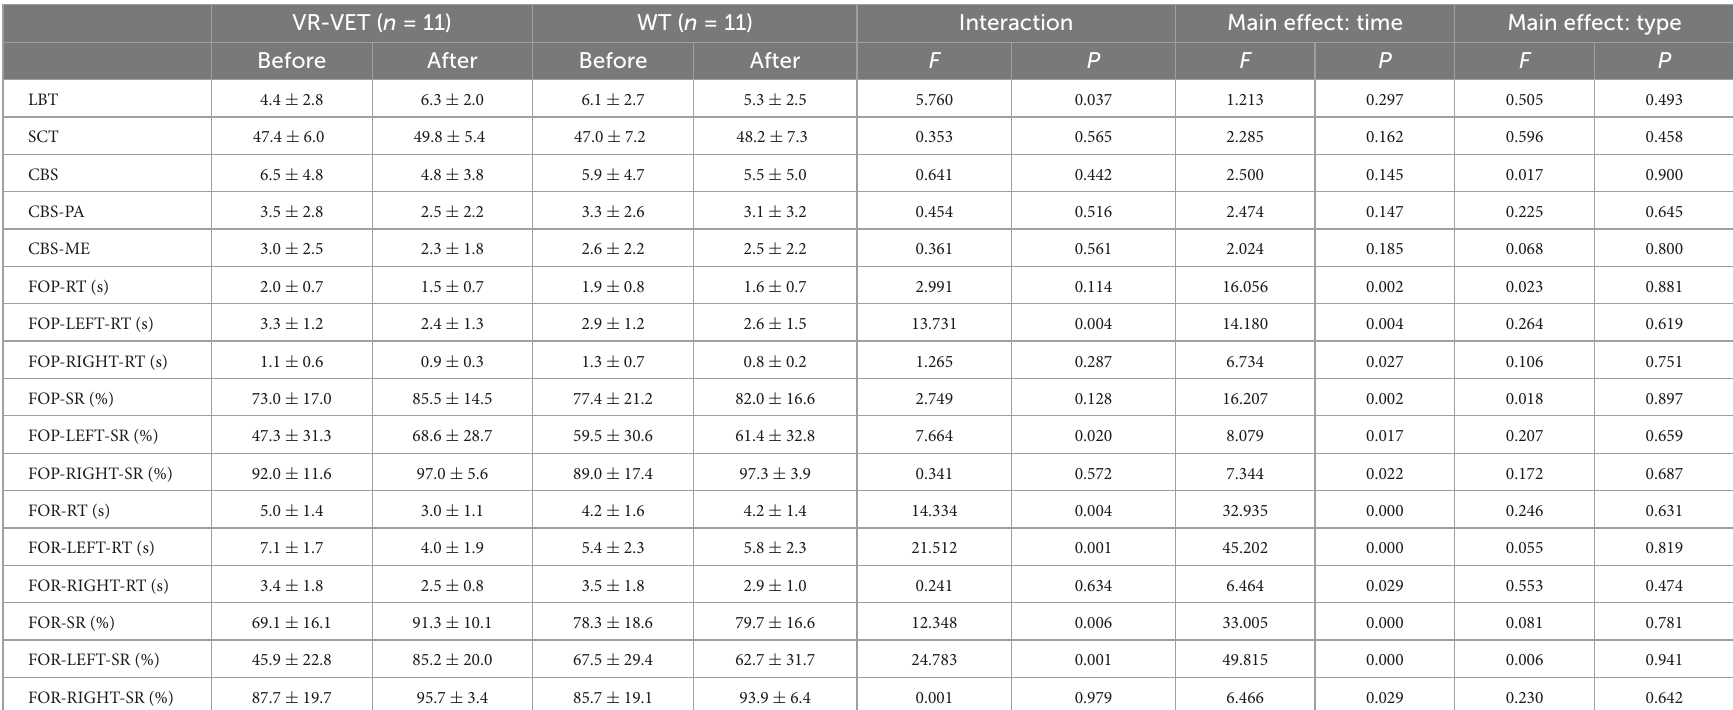
TABLE 2 Effects of VR-VET and WT on clinical HSN assessments and FOPR tests.